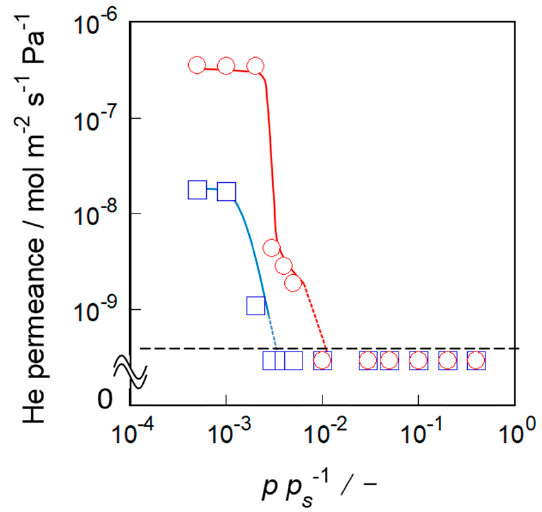
Figure 5. Results of the nano-permporometry for silicalite-1 membranes of S-1 S ( ○ ) and S-1 M ( □ ). The dashed line shows the limit of quantification (5 × 10 − 10 mol m − 2 s − 1 Pa − 1 ).